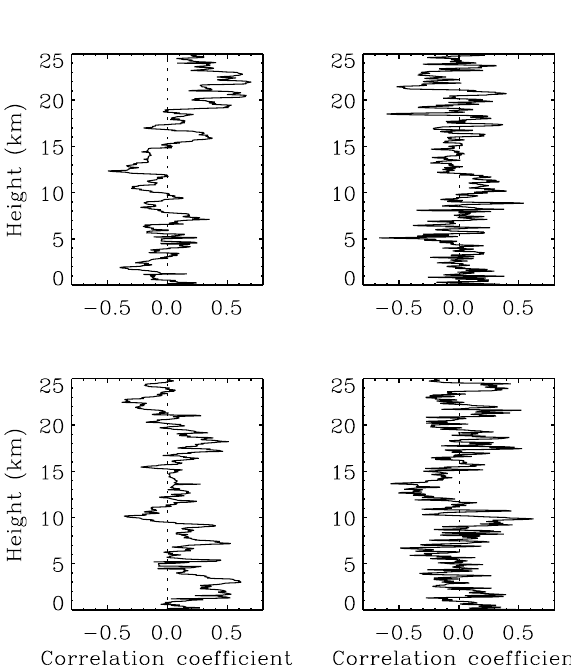
Fig. 6. Profiles of correlation coefficients of vertical shear of the horizontal wind (left column) and square of the buoyancy frequency of the moist air (right column) with GW energy densities in the tro- posphere (bottom row) and lower stratosphere (top row) in August